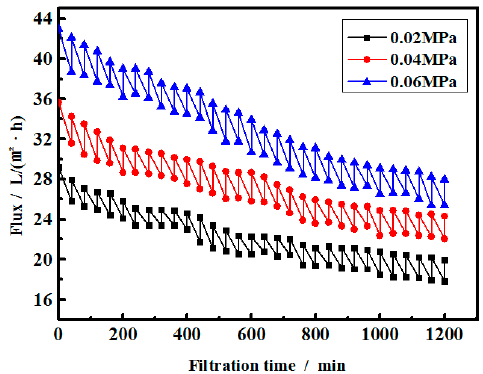
Figure 4. E ff ect of operating pressure on ultrafiltration (UF) flux. Figure 4. Effect of operating pressure on ultrafiltration (UF) flux. Table 2. Analysis of UF